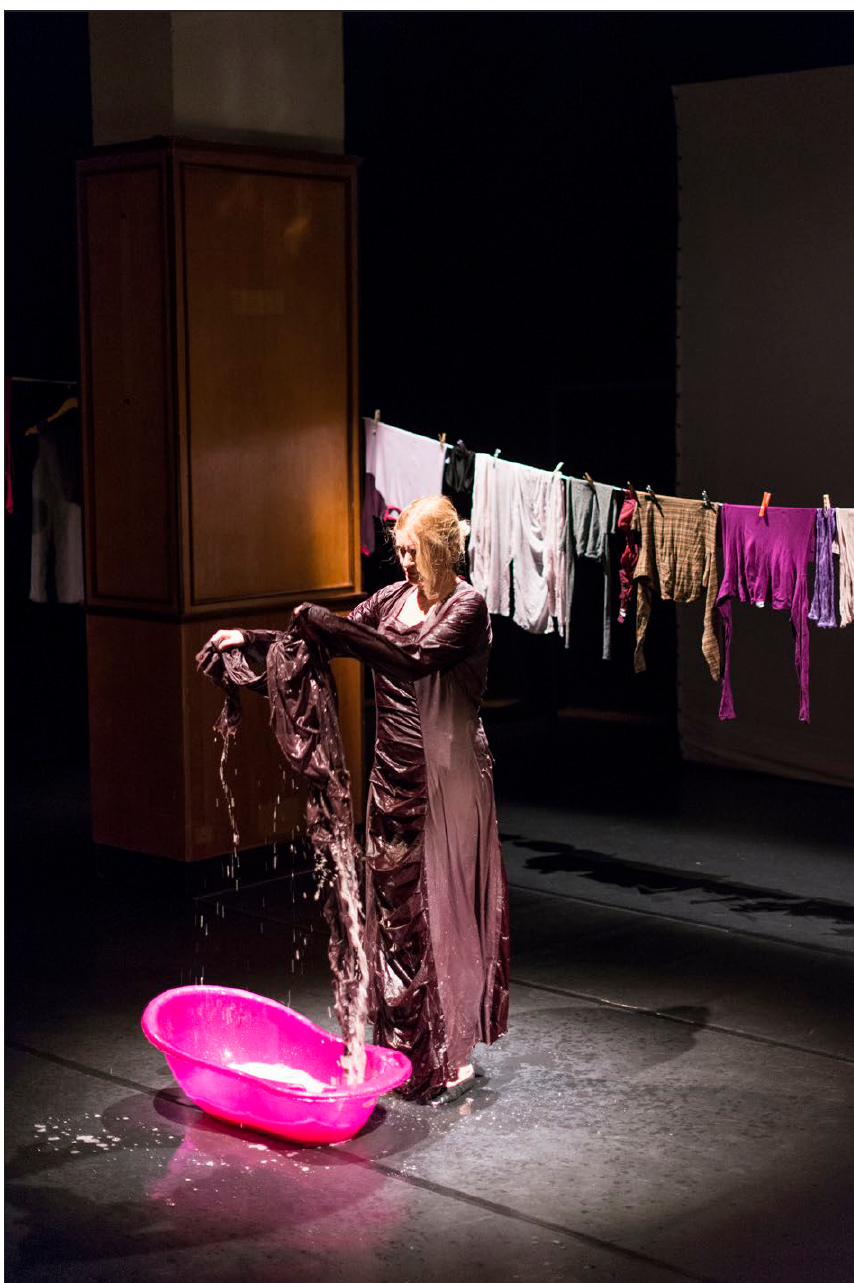
Figure 38: Lena Šimi ć , Lena in Medea/Mothers’ Clothes performance , Studio 12, Bratislava, February 2016, Photo by Jakub Č